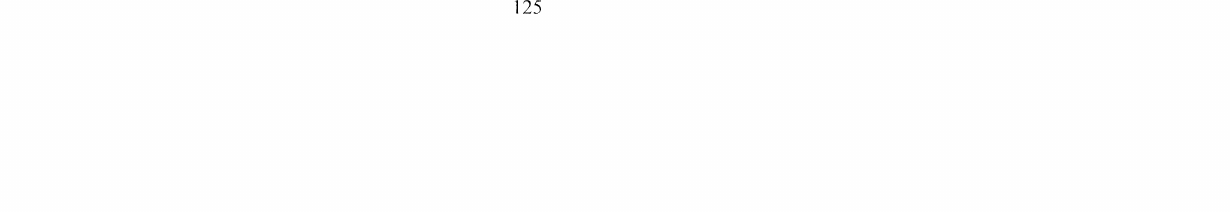
The development of a labyrinthine pattern in a chemical reaction due to an interface instability (from Lee et al. [3], reproduced with